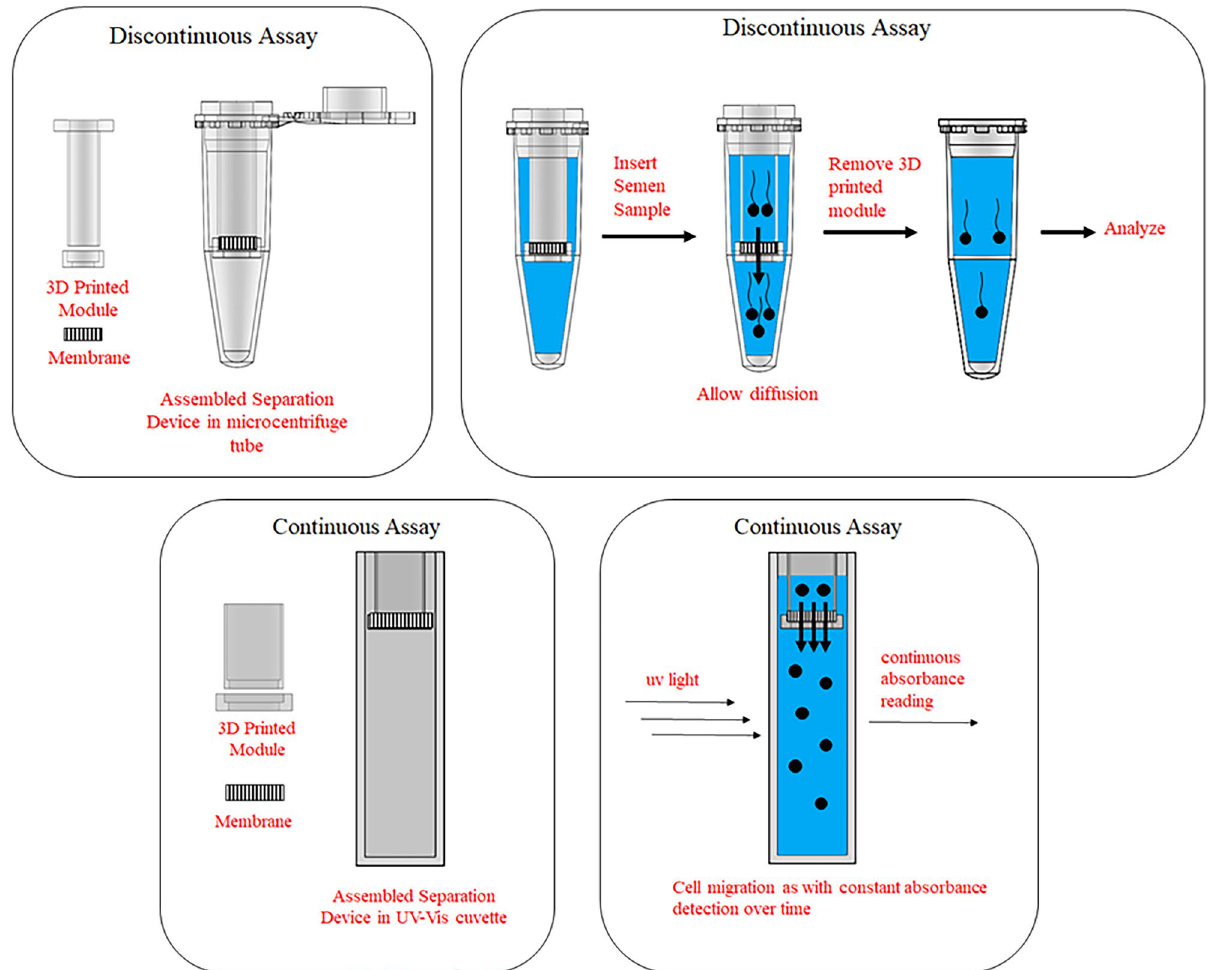
Figure 4. Designed 3D printed modules and their intended vessels. The 3D printed module for the discontinuous assay is utilized in a microcentrifuge tube, while cuvette is used for the continuous assay. Process diagrams are show per respective